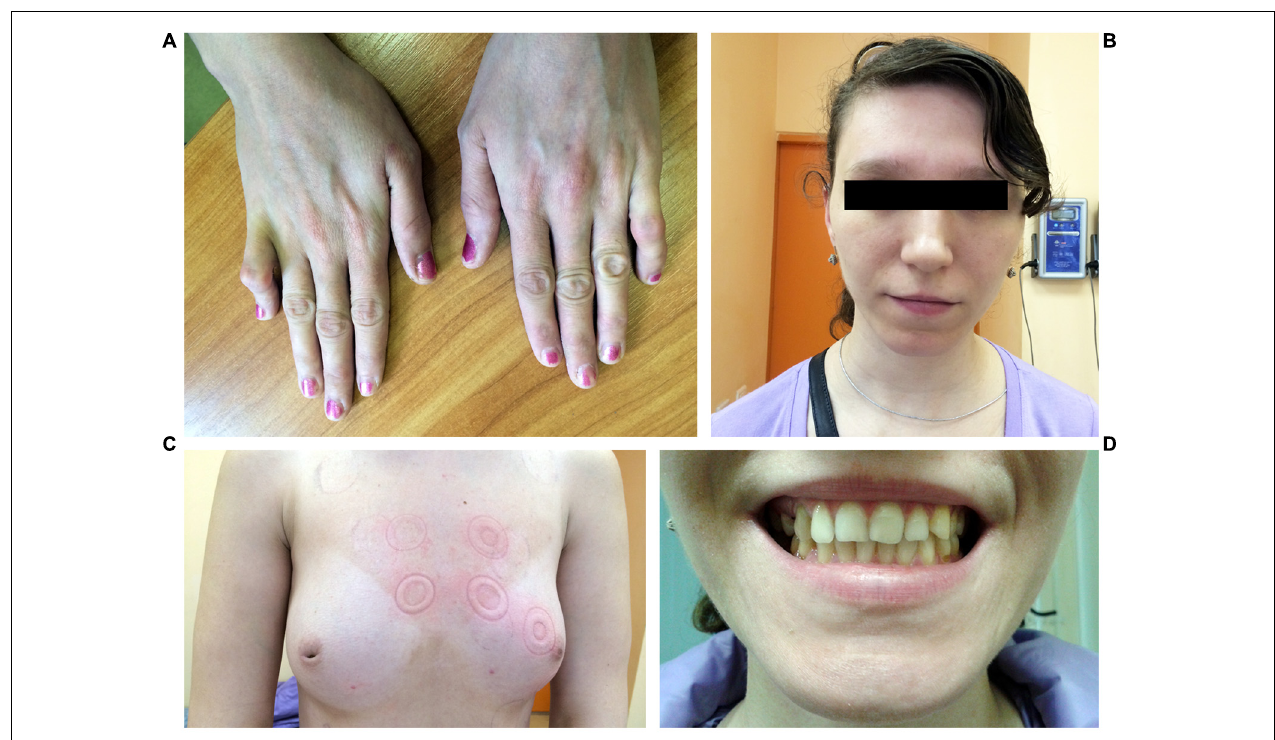
FIGURE 1 | Photographs representing phenotype of the patient. (A) Hands demonstrating fifth finger camptodactyly. (B) Facial features include wide-set eyes, strabismus, a broad nasal tip, and thin upper lip vermilion. (C) Hypoplastic breast with inverted nipples. (D) Dental abnormalities involving canines and back